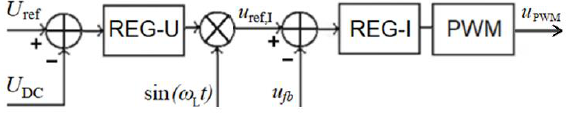
Fig. 2. Block diagram of the control system of one-phase full bridge rectifier with current modulator.